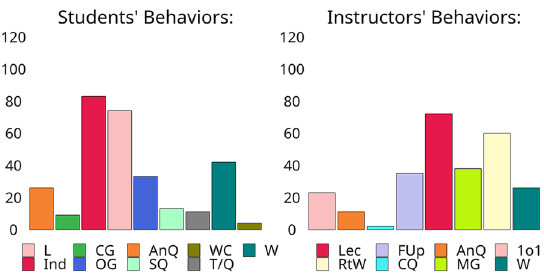
Fig. 6 Histograms of the COPUS behaviors over the Later